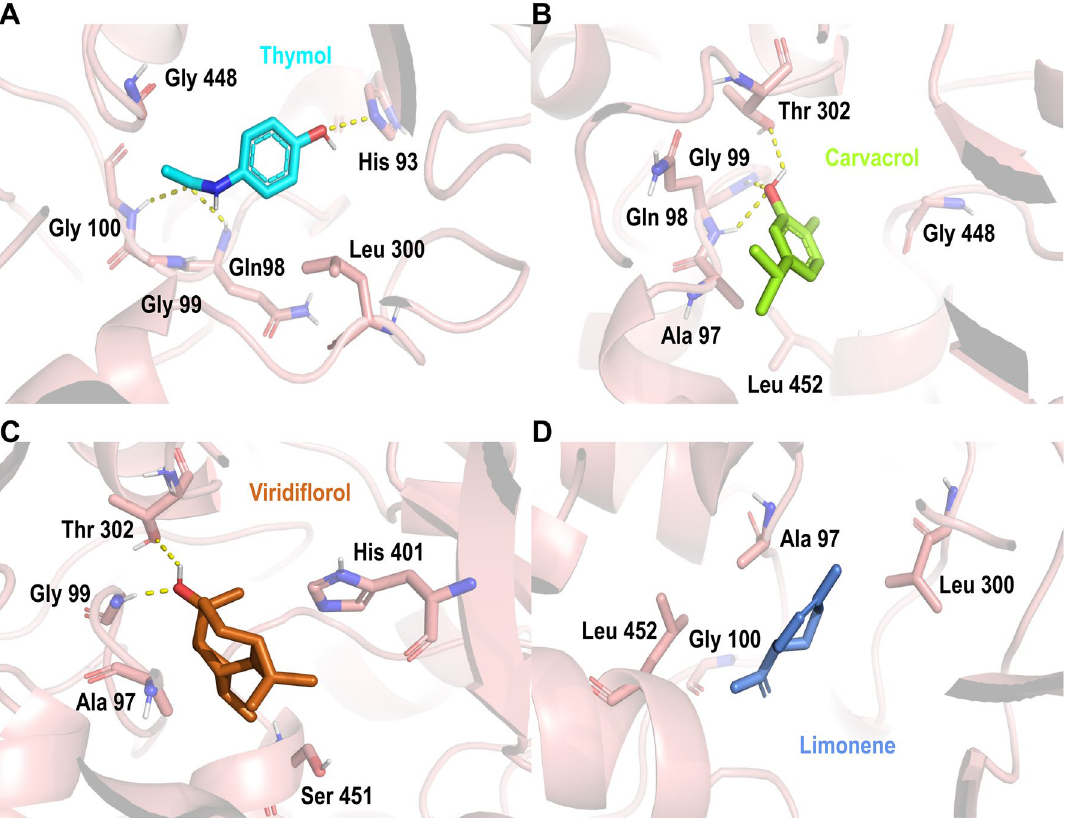
Figure 6. Docking poses of Best ranked secondary metabolites on subunit A of mitochondrial complex II in A. aegypti . ( A ) thymol; ( B ) carvacrol; ( C ) viridiflorol; ( D ) limonene. Mitochondrial complex II’ residues are colored according to the atom type of the interacting amino-acid residues (protein’s carbon, salmon; oxygen, red; nitrogen, blue). The protein–ligand interactions are represented by dash lines as follows: hydrogen bond interactions are colored in